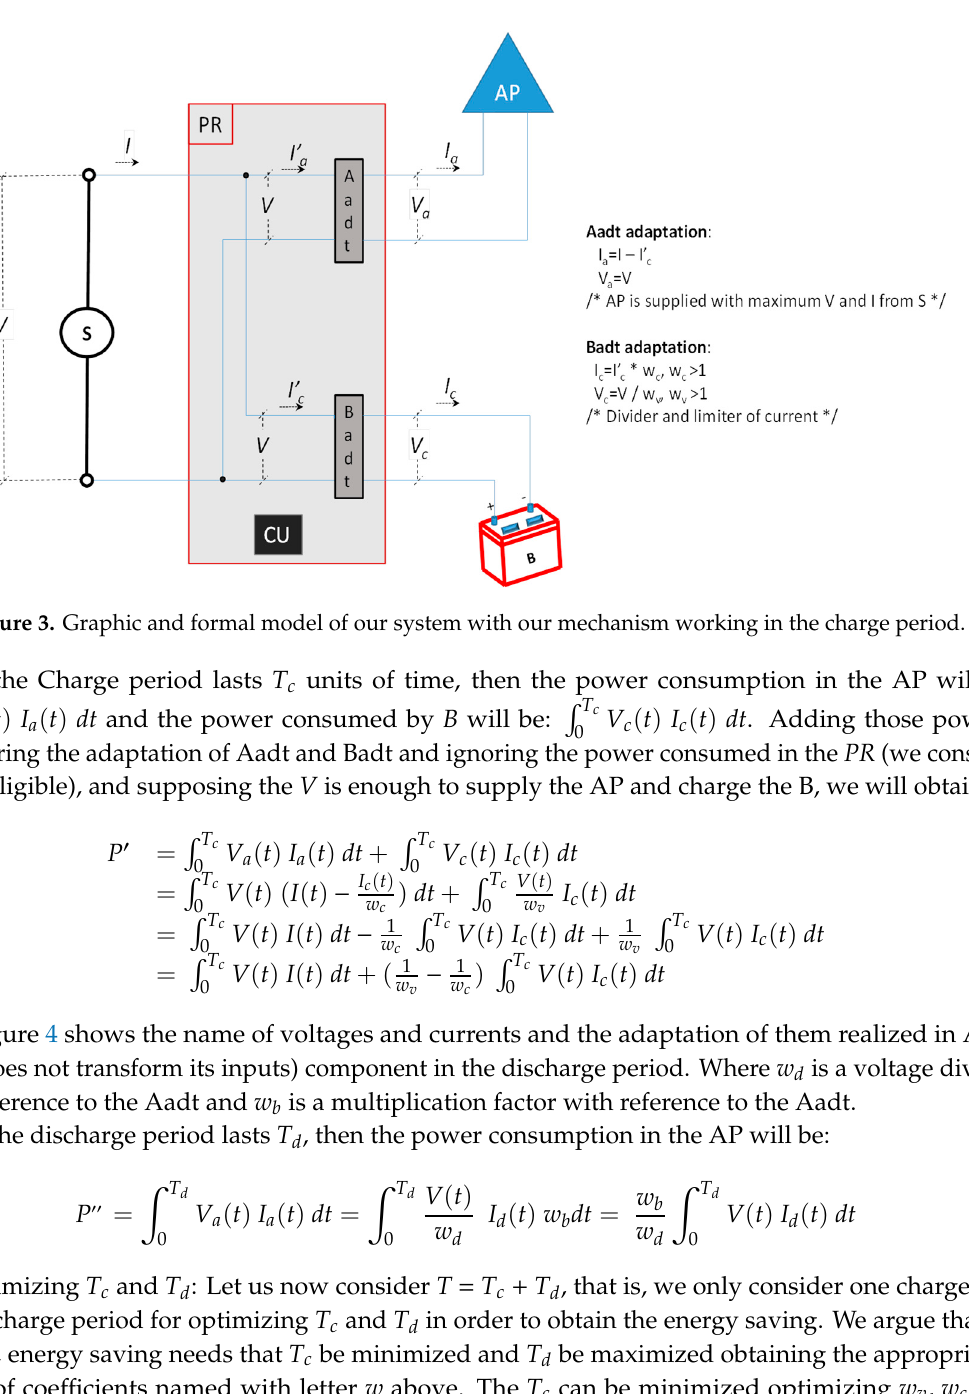
Figure 4. Graphic and formal model of our system with our mechanism working in the discharge period.